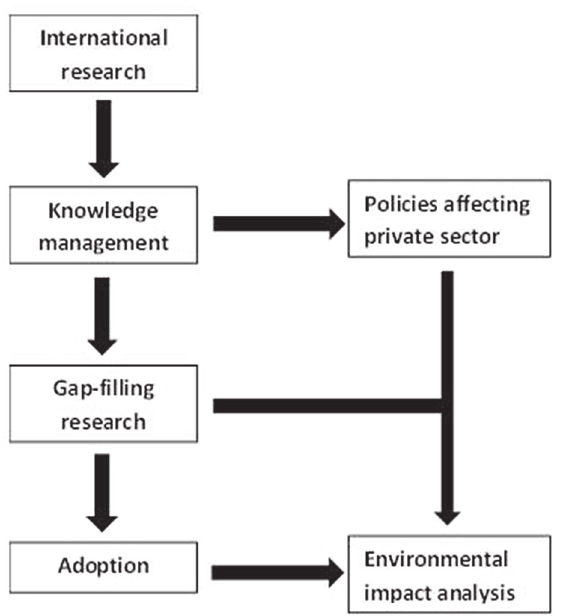
Figure 6 - A multidimensional model of agricultural technology transfer for the public